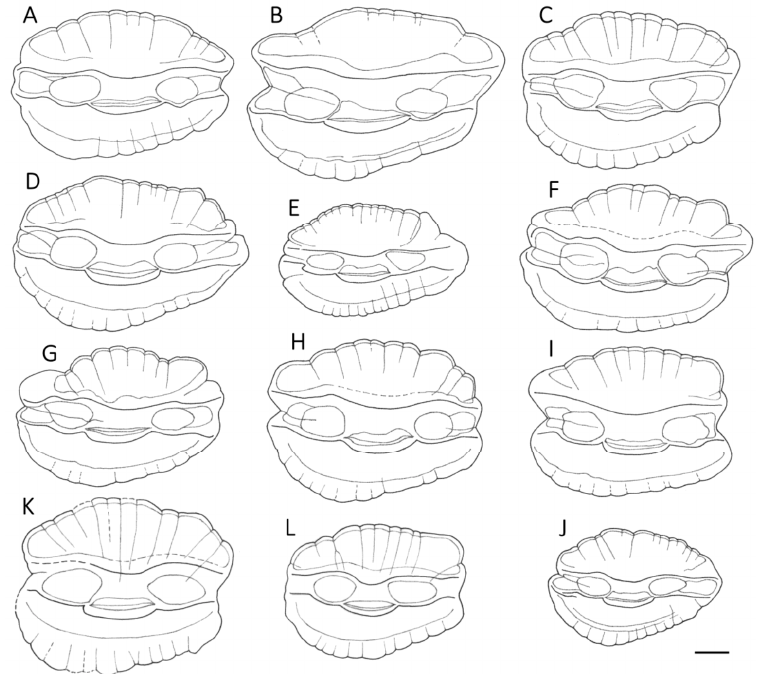
Figure 7. Otoliths of Gadiculus thori showing large morphological variability. ( A )–( J ): Recent otoliths from the Kvinnheradfjord, Hardanger, Norway. ( A ) TL 151, OL 7.12; ( B ) TL 158, OL 8.37; ( C ) TL 147, OL 6.88; ( D ) TL 151, OL 7.50; ( E ) TL 108, OL 6.07; ( F ) TL 146, OL 7.40; ( G ) TL 138, OL 6.65; ( H ) TL 164, OL 6.90; ( I ) TL 147, OL 6.42; ( J ) TL 104, OL 5.62. ( K , L ): Fossil otoliths redrawn from Girone et al. [38]